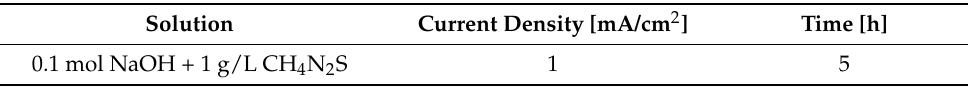
Table 2. Hydrogen charging conditions for Nakajima specimens and tensile test specimens.